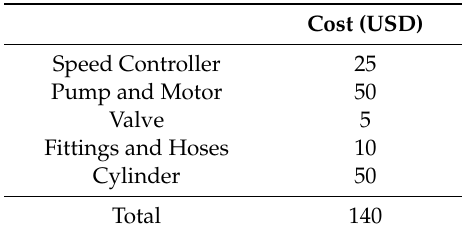
Table 7. Estimated system cost for a Valve B system.